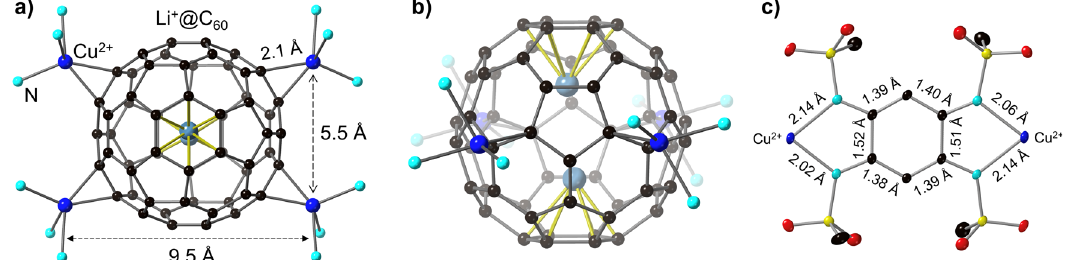
Fig. 1 Crystal structures of Cu 4 -Li + @C 60 and Cu 2 (L). a The coordination geometry of [Cu(N) 3 ] 4 (Li + @C 60 ) and the arrangement of Li-ion. One Li + @C 60 coordinates with four Cu ions. The four Cu ions form a rectangular-like plane with a length and width of 9.5 and 5.5 Å, respectively. b The Li-ion coordinates with six carbon-ring and locates above or below the Cu-plane with thermal ellipsoids at the 50% probability. The Cu-plane perfectly splits the Li + @C 60 cage in half. c The structure of the donor, Cu 2 (L) and its bond length. Colour code: C (black), Cu (blue), N (cyan), S (yellow), O (red) and Li (pastel